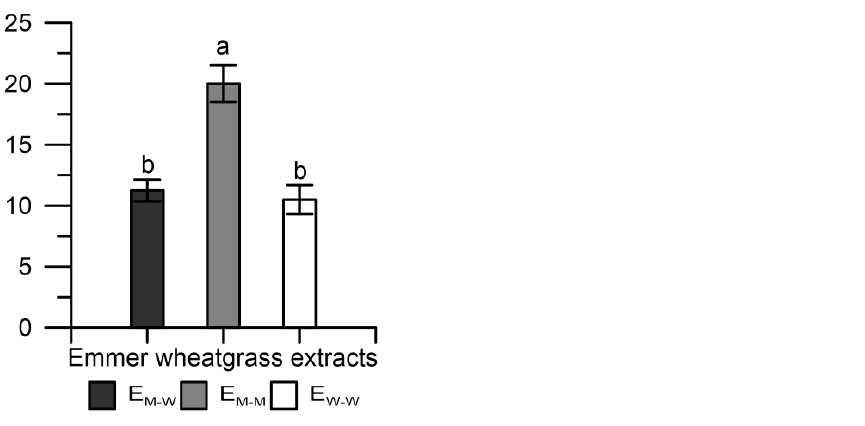
Figure 1. Activity of emmer wheatgrass extracts obtained from emmer grains sprouted with distilled water on the cytosolic Ca 2+ of maize pollen. E M-W , extracted with methanol and resuspended in water; E M-M , extracted with methanol and resuspended in methanol; E W-W , extracted with water and resuspended in water. Data are expressed as means ± SEM from five independent tests. Different letters above bars indicate significant differences at p ≤ 0.05, whereas same letters indicate non-significant differences.